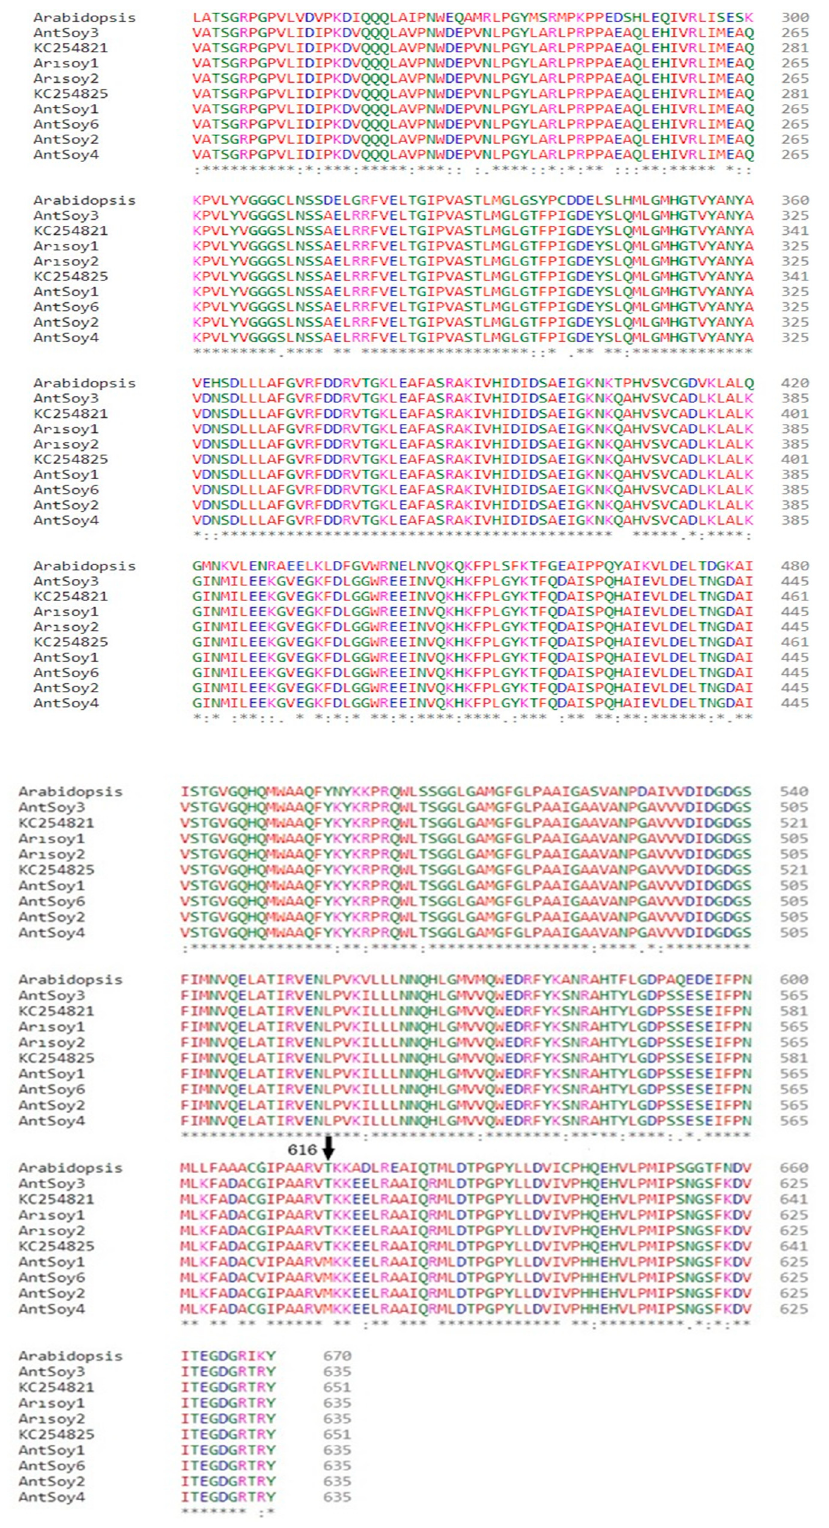
Figure 4. Protein sequence analysis amplified with the GmAHAS1 primer and made with the Clustal Omega program; Arabidopsis thaliana reference plant; KC254821, herbicide resistance soybean plant; KC254825 herbicide susceptible soybean plant; Progeny of herbicide resistant soybean mutant AntSoy 1, 2, 3, 4, 6; herbicide sensitive wild-type Arısoy1, 2 variety (arrows indicate with amino acid change points) .